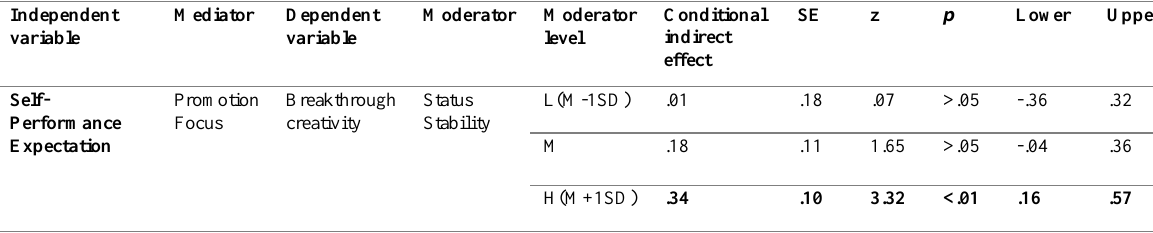
Table 5: Conditional indirect